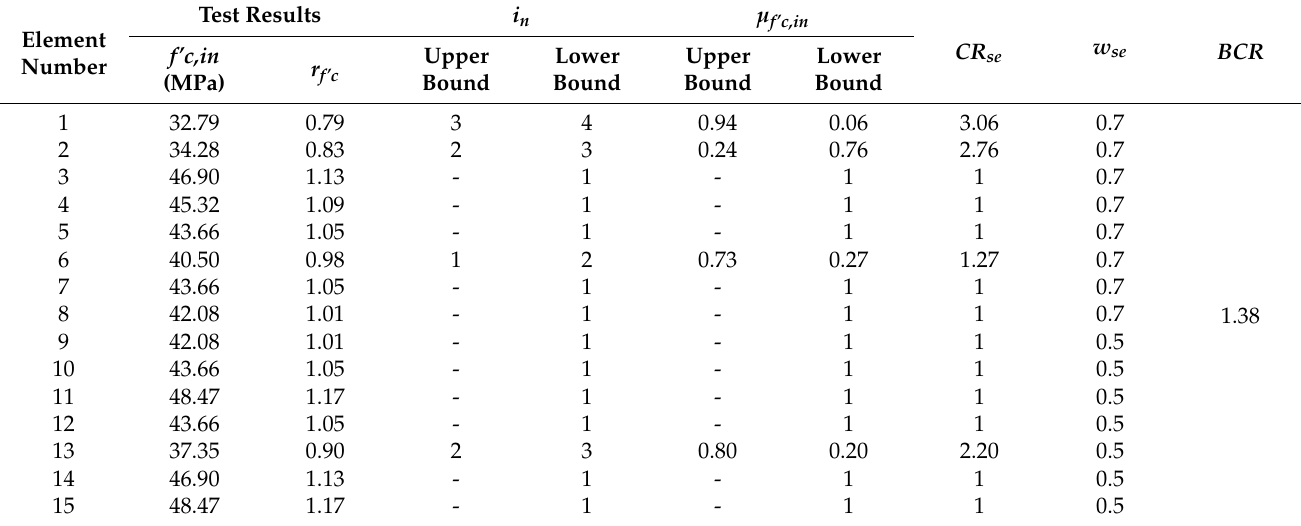
Table 6. Building A condition rating